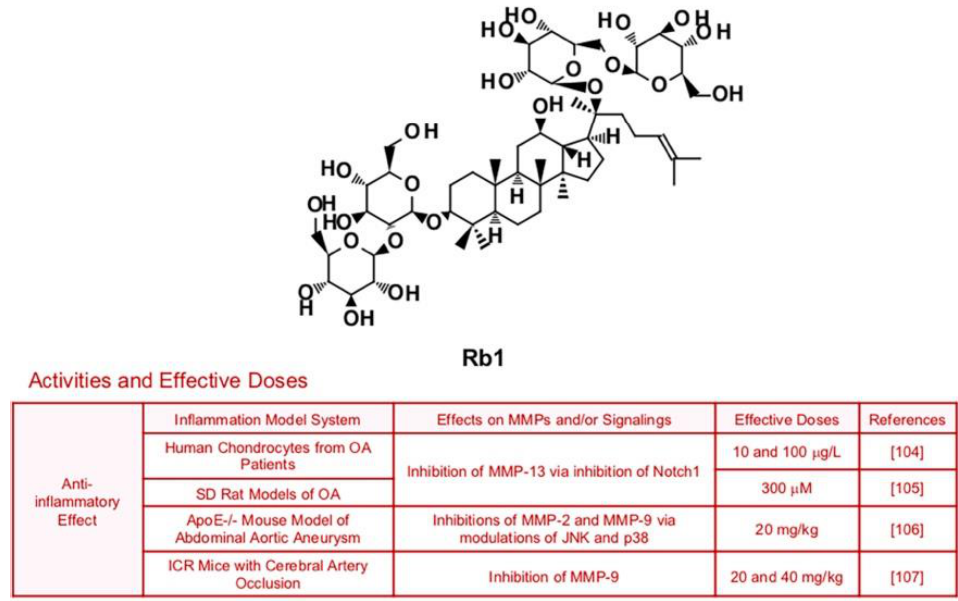
Figure 7. Summary of activities of ginsenoside Rb1. Structure of Rb1 and its effects on MMPs and/or signalings [104–107].